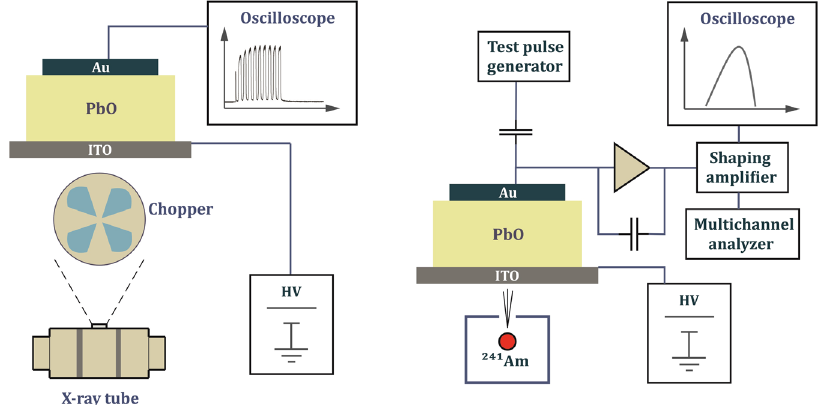
Figure 8. Schematic representation of the XPM apparatus ( a ) and PbO-based pulse height spectrometer with a virtual ground input to charge amplifier ( b ). The exposure was applied from the ITO